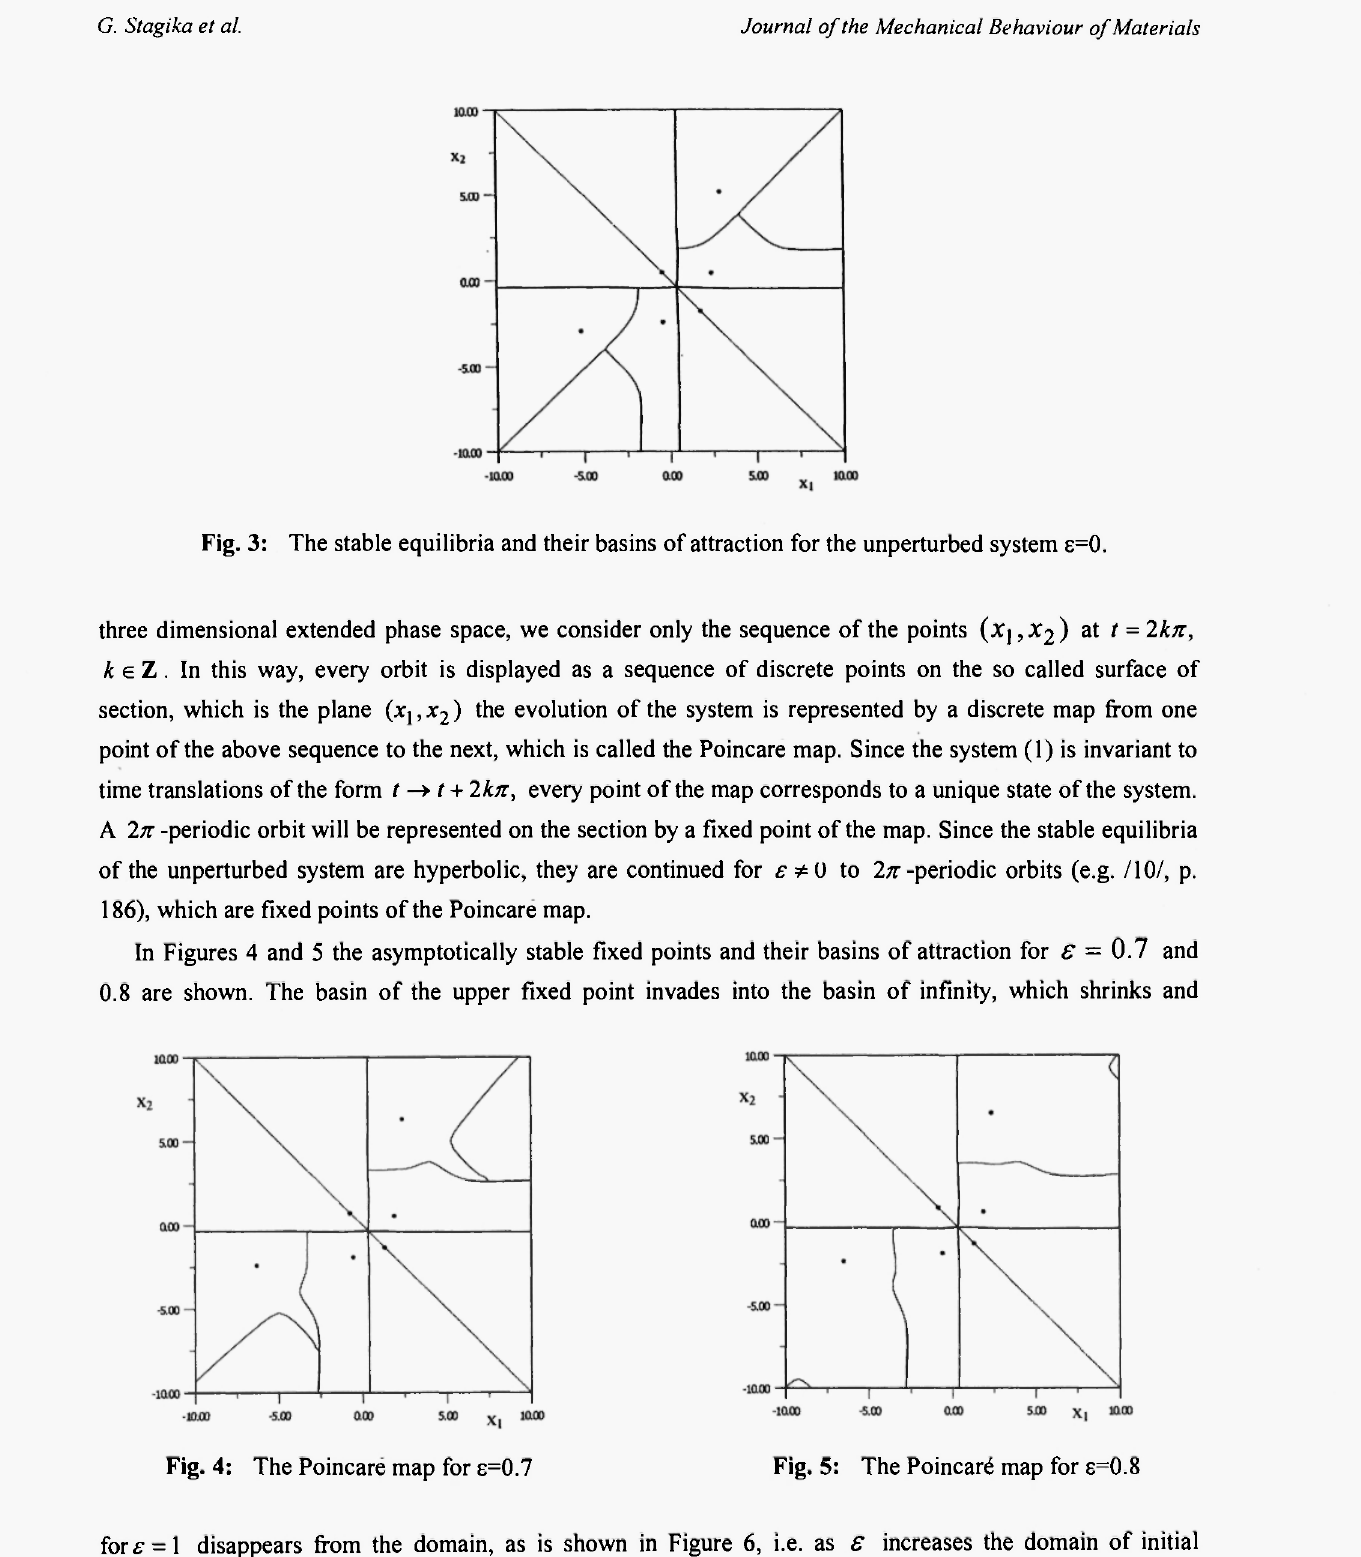
Fig. 4: The Poincare map for ε=0.7 Fig. 5: The Poincar£ map for